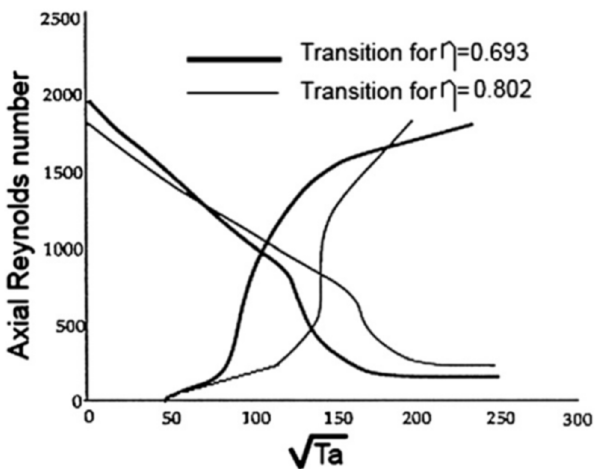
Figure 6. Taylor and axial Reynolds number flow transition: Influence of annulus thickness